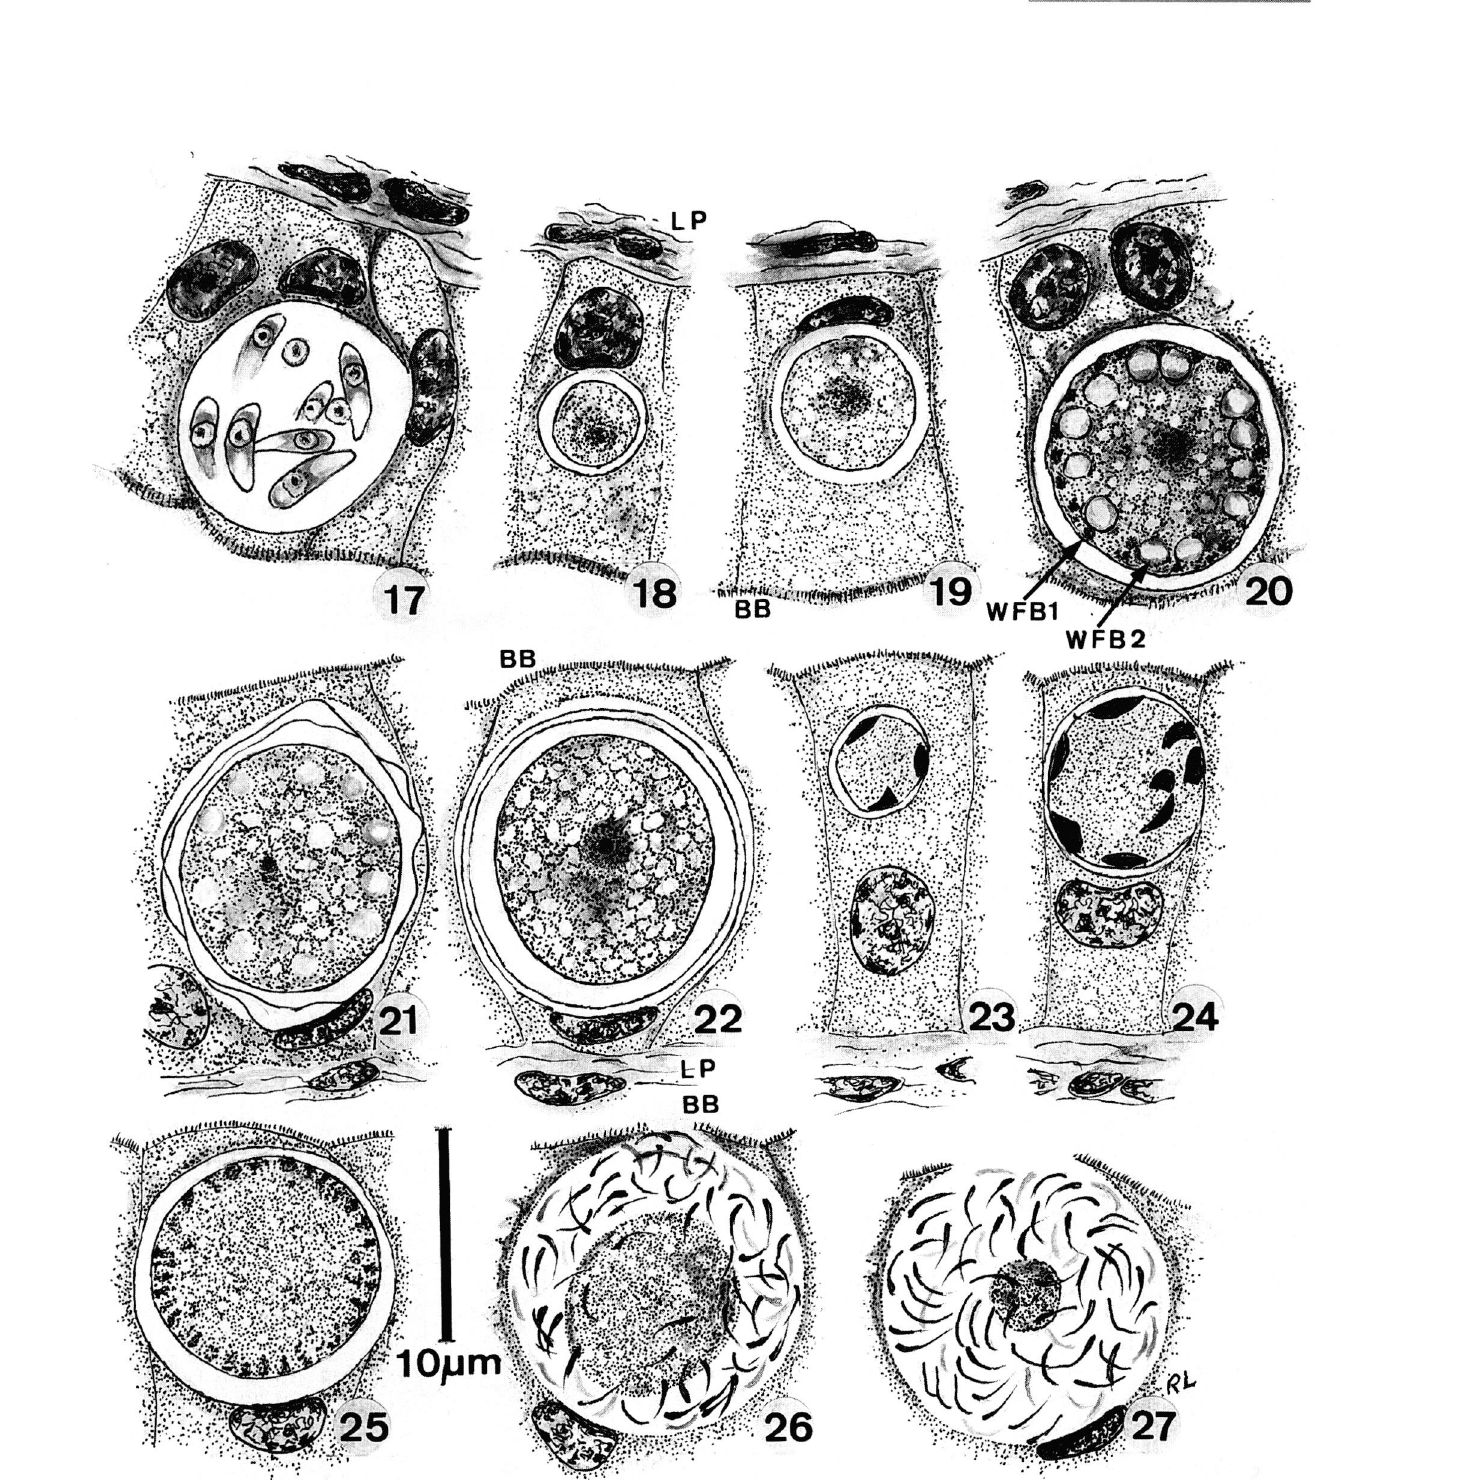
Figs 17-27. - Line-drawings of the endogenous stages of Eimeria bragancaensis n. sp. in the small intestine of the bat Peropteryx macrotis. Fig. 17. Segmented meront. Figs 18, 19. Developing macrogamonts. Fig. 2 0. Mature macrogamont. Figs 21, 2 2. Young oocysts, with thin, inner layer of the oocyst wall. Figs 23-25. Developing microgamonts. Figs 26, 27. Mature microgamonts shedding microgametes and lea­ ving a residuum of variable